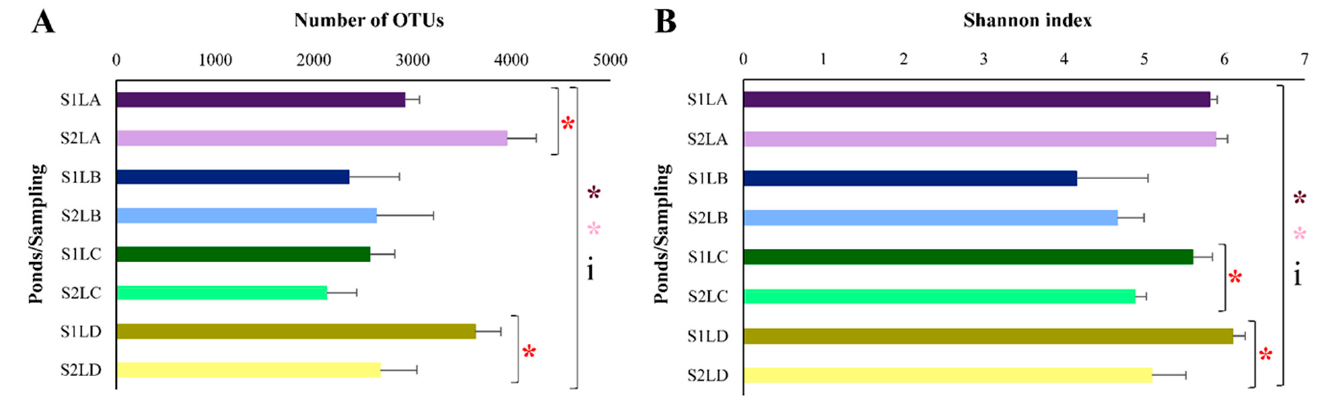
Figure 2. Alpha diversity evaluated by massive sequencing of the gene encoding 16S rRNA in water samples collected in LA (purple), LB (blue), LC (green) and LD (yellow) in S1 (high rainfall period— dark tones) and in S2 (low rainfall period—light tones). The bars represent the standard deviation. Species richness and alpha diversity showed significant differences between the ponds in the two samplings (parametric data submitted to a one-way ANOVA) represented by asterisks (dark pink for S1 and light pink for S2). A red asterisk represents the significant difference among the ponds at each sampling (parametric data submitted to the t test). The data were also submitted to a two-way ANOVA, and the interaction between the factors is represented by the letter i. ( A ) Richness evalu- ated by the number of OTUs; ( B ) Shannon diversity index.